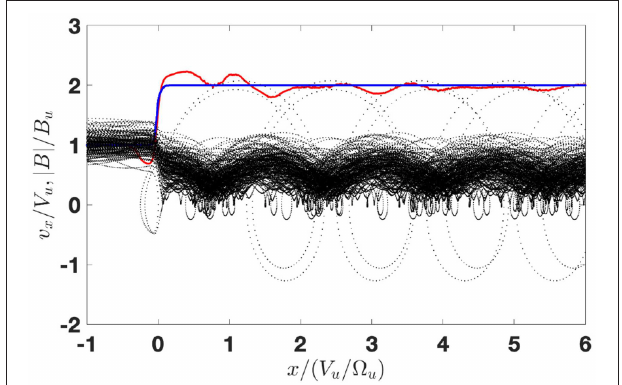
FIGURE 3 | Ion orbits represented as x vs. v x , with the magnetic profile on the background.